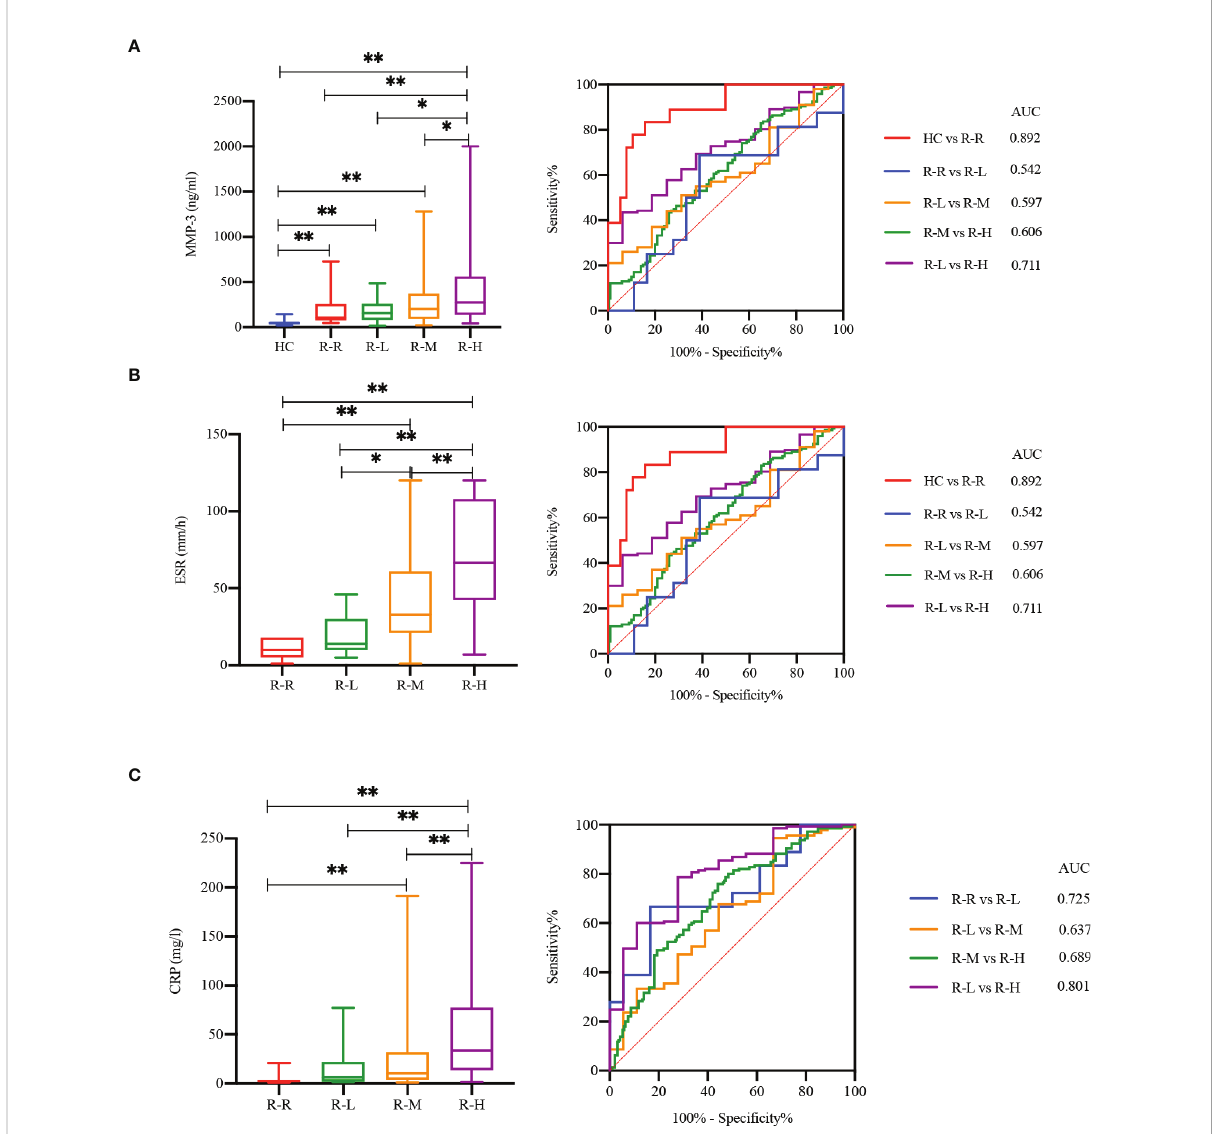
FIGURE 5 MMP-3 (A) , ESR (B) and CRP (C) correlated with RA disease activity. Boxplots and ROC analysis of the level differences of four markers between HC, RA with remission stage [R-R, DAS28-ESR (3) < 2.6], low disease activity [R-L, DAS28-ESR (3) ≤ 3.2], moderate disease activity [R-M, 3.2 < DAS28-ESR (3) ≤ 5.1] and high disease activity [R-H, DAS28-ESR (3) > 5.1]. * p < 0.05, ** p <